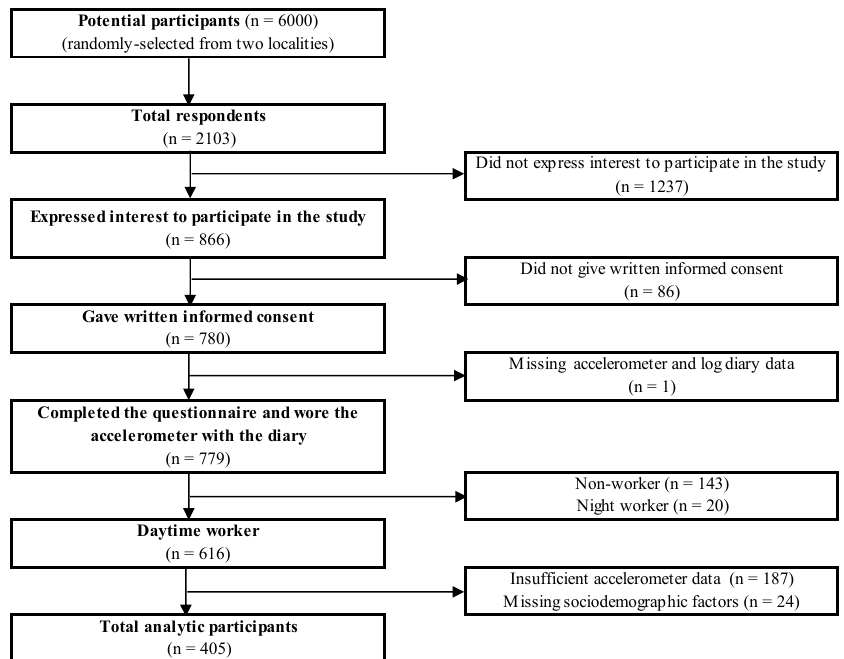
Figure 1. The flowchart of participant recruitment.